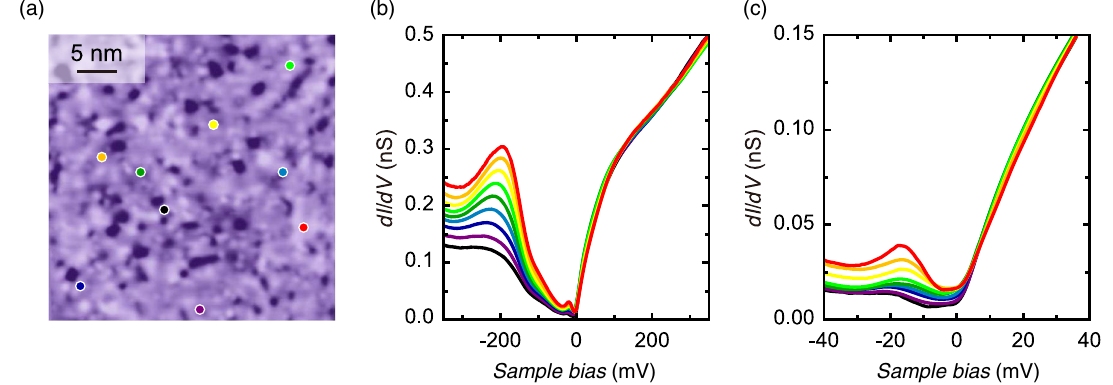
FIG. 3. (a) STM topography on the x ¼ 0 . 14 sample acquired with V ¼ − 50 mV and I ¼ 40 pA. (b) dI=dV curves taken at locations marked by the colored dots in (a) with set-up conditions V ¼ 400 mV and I ¼ 180 pA. A close-up look into energy range around E F is displayed in